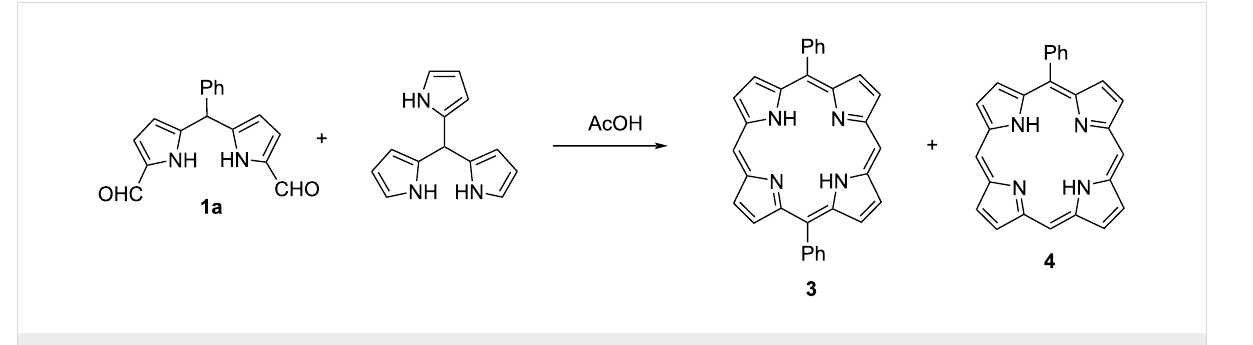
Figure 2: Electronic absorption spectrum of 2a in CHCl 3 .